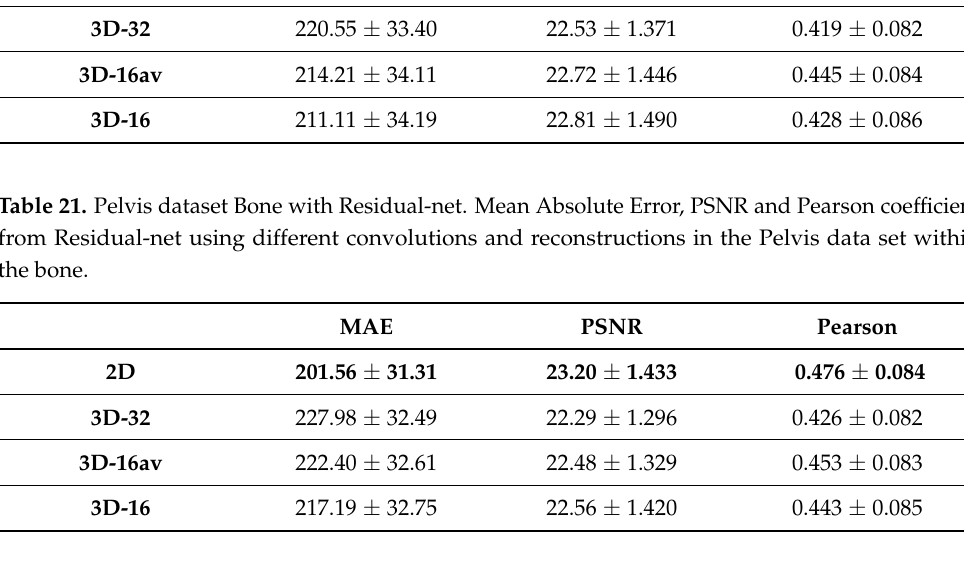
Table 22. Pelvis dataset Fat with U-Net. Mean Absolute Error, PSNR and Pearson coefficient from U-net using different convolutions and reconstructions in the Pelvis data set within the fat. MAE PSNR